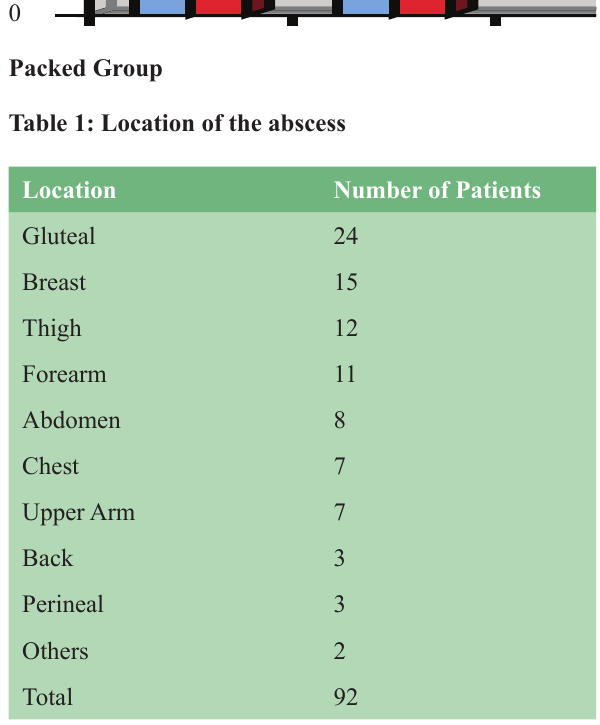
Table 2: Intervention needed in the both groups